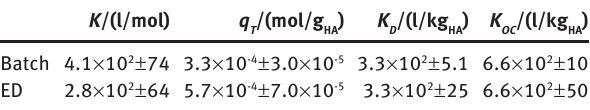
Figure 2 Adsorption isotherm of 2,2′-bipyridine (BP), obtained by batch experiment (background electrolyte: 10 -2 mol/l CaCl at room temperature).